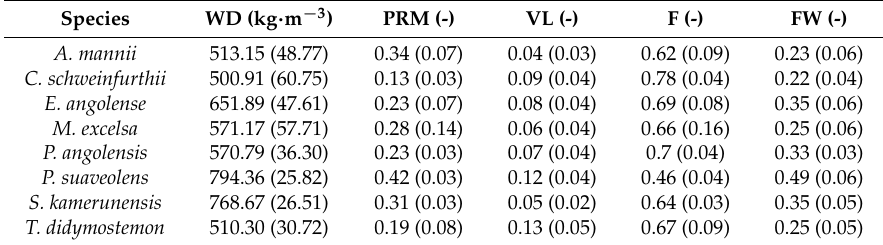
Table 2. Measured values of the 8 tested samples. Wood density (WD, kg/m 3 ), parenchyma fraction (PRM), vessel lumina fraction (VL), as well as fibre (F) and fibre wall fraction (FW, defined as the fibre wall width divided by the sum of fibre wall and lumen diameter). Standard deviation is given between brackets.